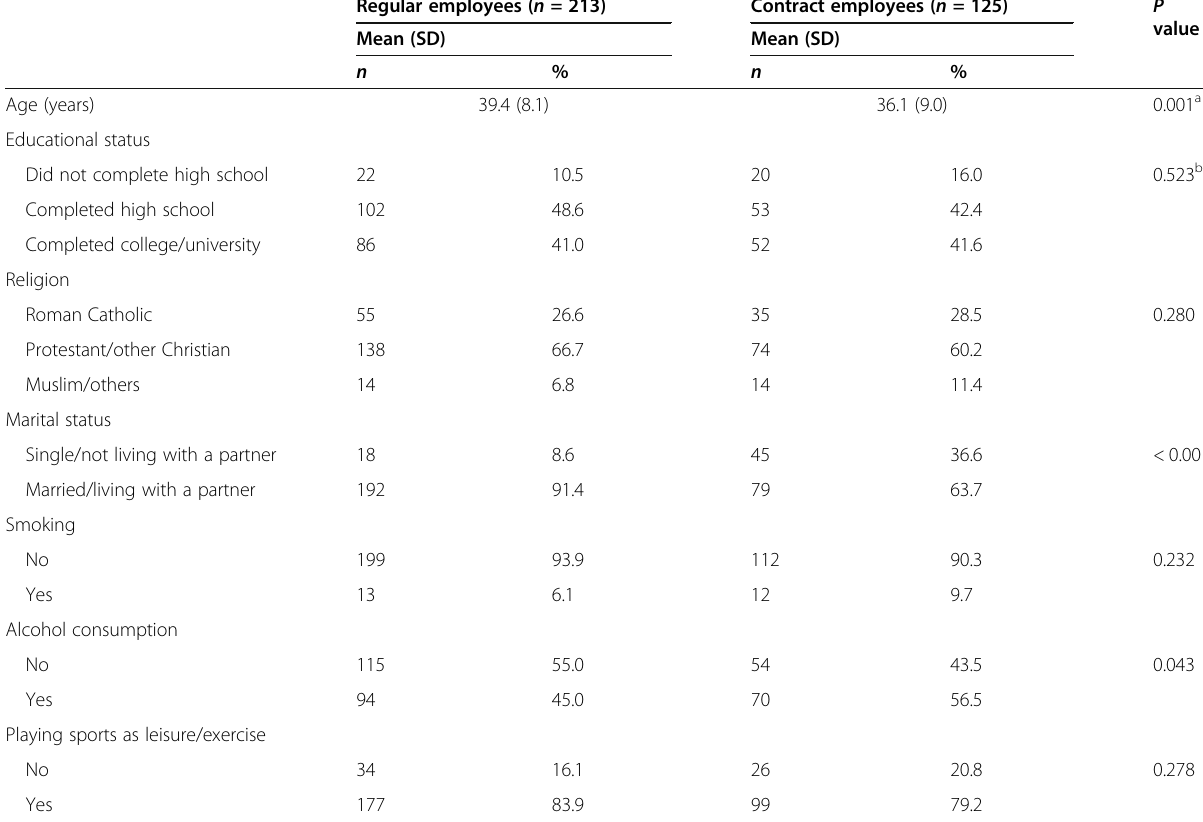
Table 1 Demographic characteristics and daily life habits of the study participants ( n = 338) Regular employees ( n =